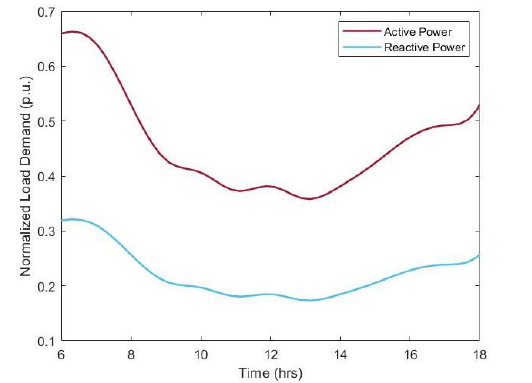
Figure 5. Variation of the load demand during the simulation